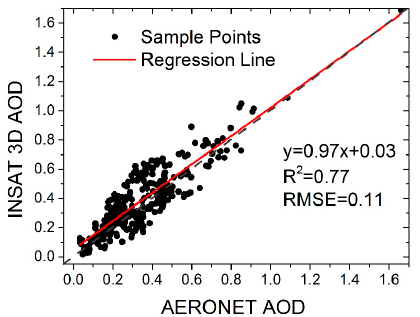
Figure 5. Validation of retrieved INSAT 3D AOD and AERONET in-situ AOD: solid line denotes the leaner regression line while dash line denotes the 1-1 line.